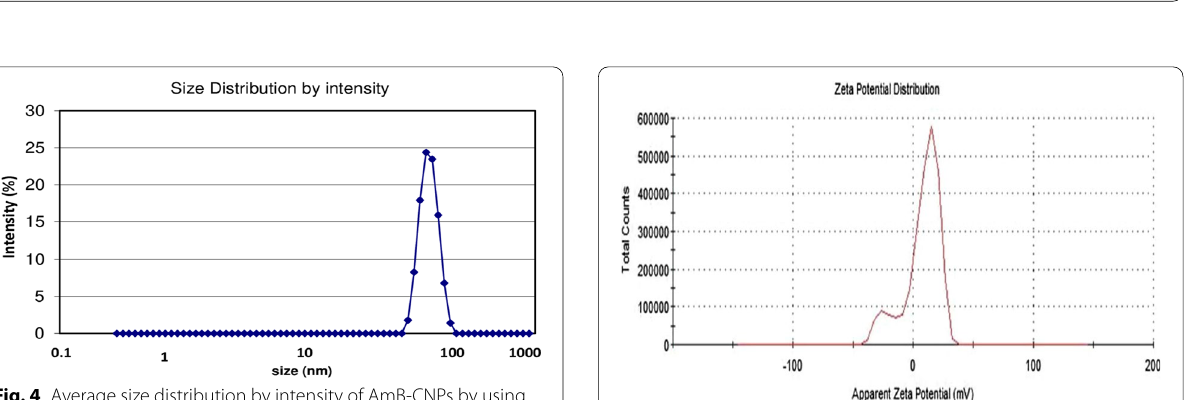
10,000 and 40,000 magnifications × ×